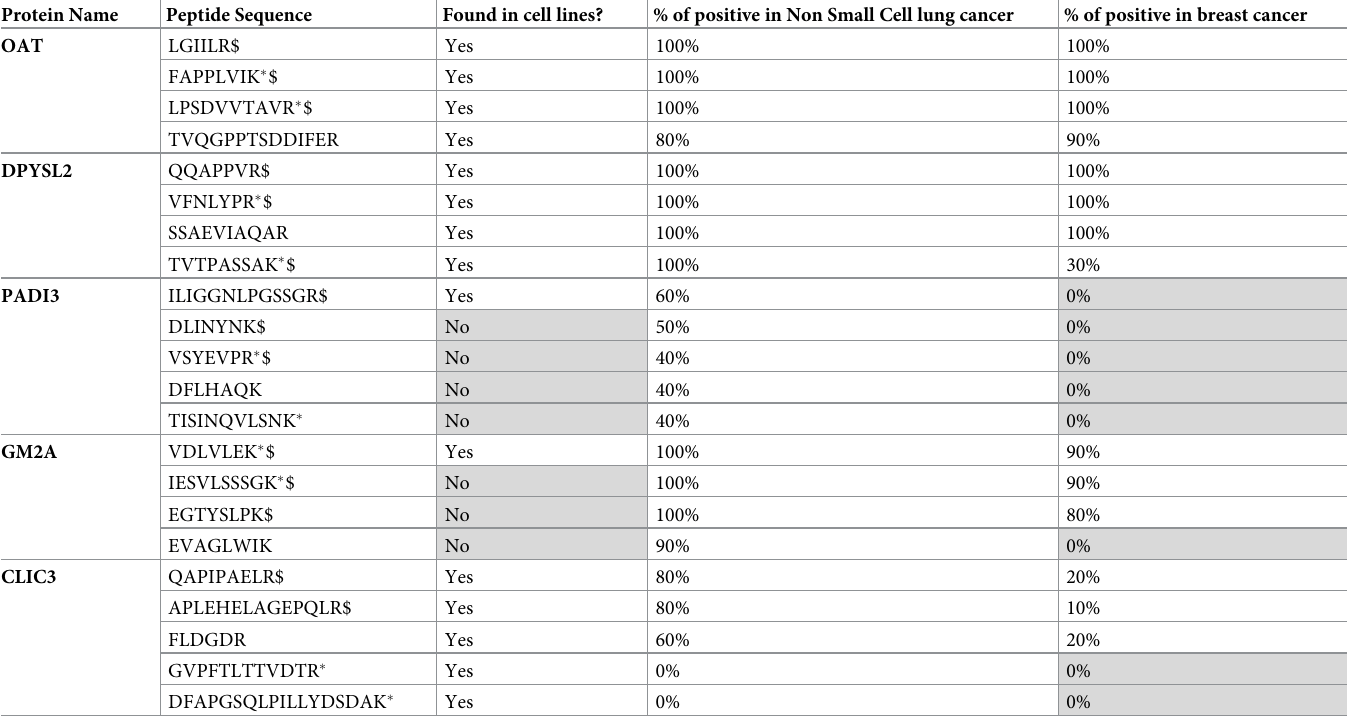
Table 2. SRM reporting peptides assessed in the 5-protein signature in cell lines and in breast and lung